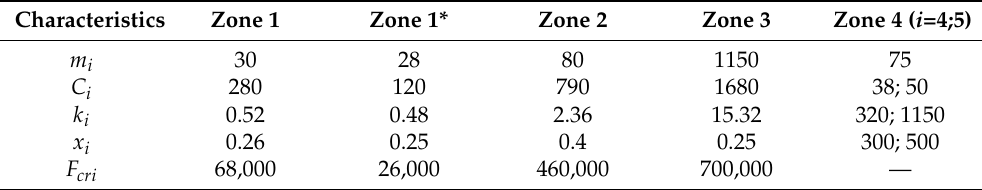
Table 2. Calculation data for Toyota Yaris.